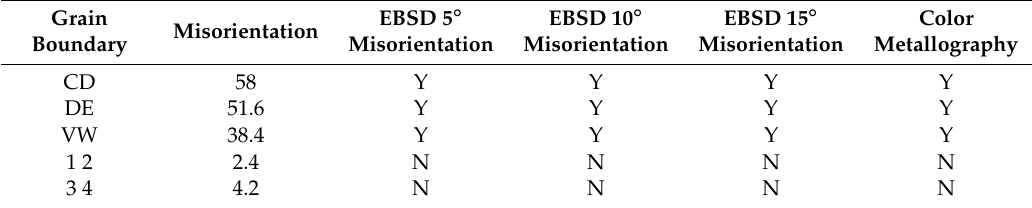
Figure 5. Thixocast sample, copper mold, poured at 690 °C; ( a ) polarized light image with sensitive tint plate, polished and anodized with Barker’s reagent, ( b ) IPF map, ( c ) 5° grain map, ( d ) 10° grain map, ( e ) 15° grain map. Table 3. EBSD data for thixocast sample, copper mold, poured at 690 °C (Y, Yes; N, No).